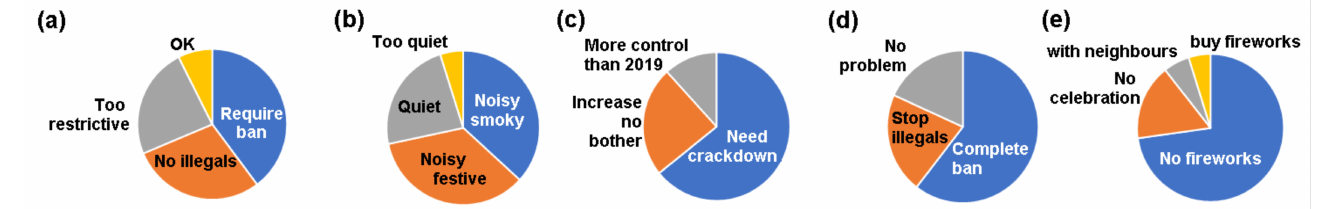
Figure 5. Results of ad hoc surveys in the Honolulu Star Advertiser asking a range of questions over the years ( a ) 31 December 2016: What do you think about the use of fireworks on New Year’s Eve? ( b ) 1 January 2018: How was the fireworks situation in your neighbourhood (or where you were) on New Year’s Eve? ( c ) 3 January 2020: What’s your general reaction to the fireworks in neighbourhoods on New Year’s Eve? ( d ) 5 January 2021: What do you think about how the New Year’s Eve/Day fireworks played out? ( e ) 27 December 2021: Are you celebrating New Year’s Eve with fireworks? Note: Survey data Honolulu Star Advertiser at dates